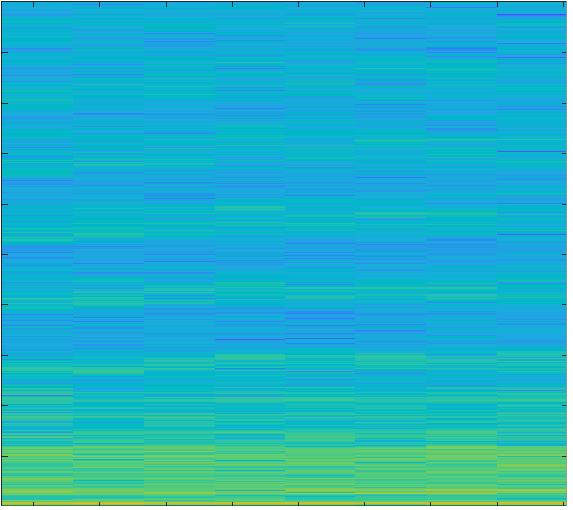
Figure 16. Softwood, Worn-out Tool, 2 mm depth-of-cut.